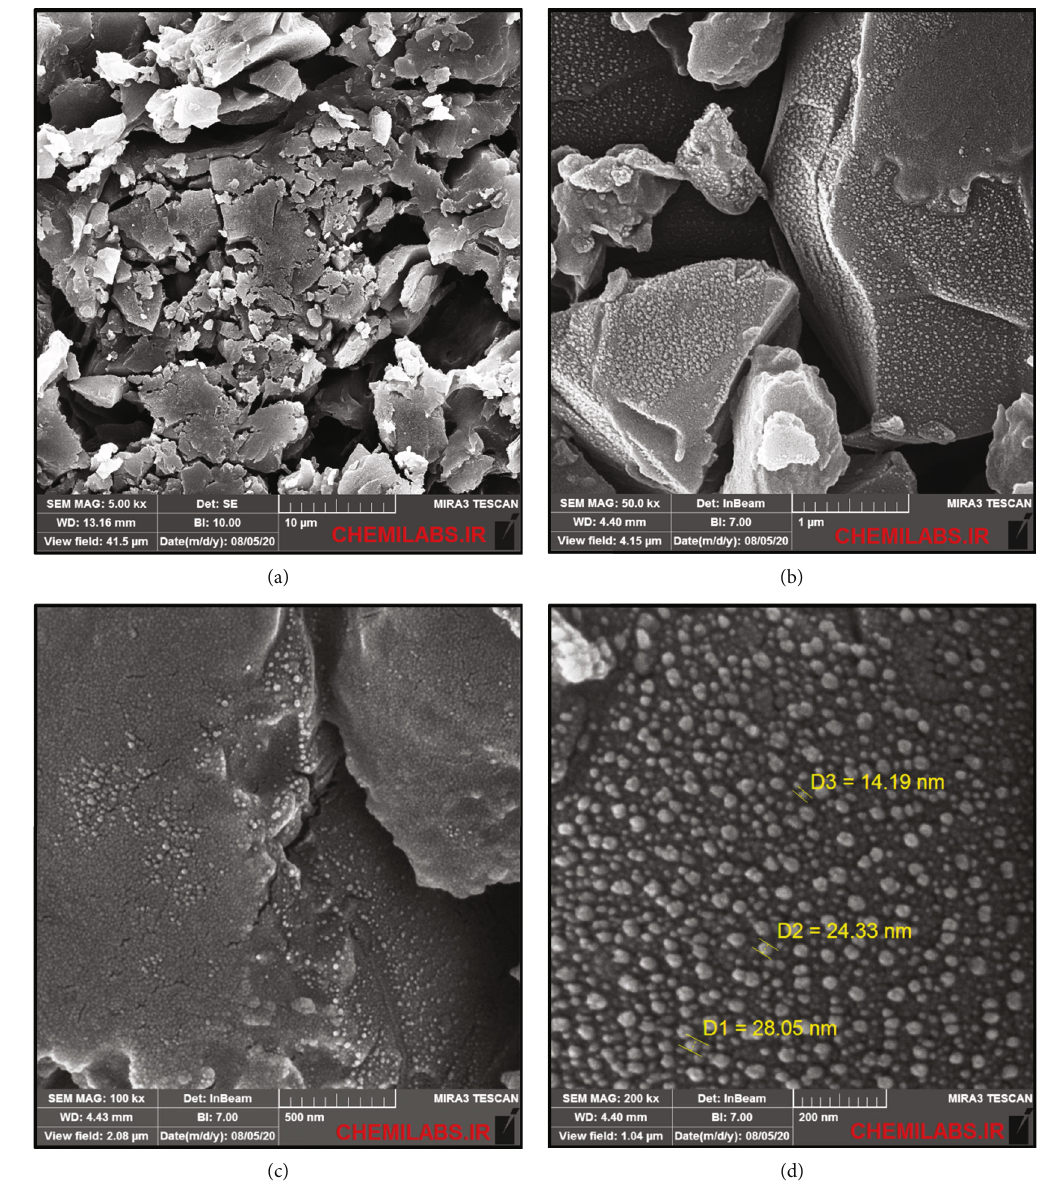
Figure 11: SEM micrographs of PUr-NGQD nanocomposites. (a) × 5000, (b) × 50000, (c) × 100000, and (d) ×